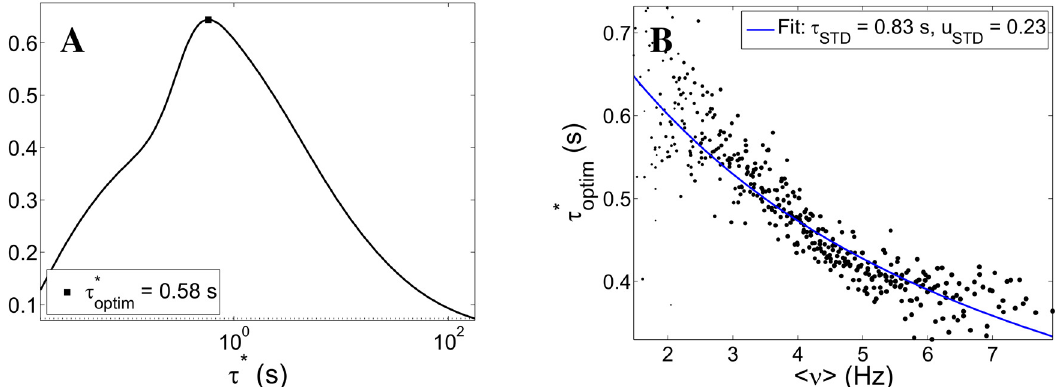
Fig 7. Slow time-scales inference procedure: test on simulation data. Panel A: correlation between low-pass filtered network activity f (see Eq 19) and the size of the immediately subsequent network spike plotted against the time-scale τ * of the low-pass integrator (continuous line). The correlation presents a clear (negative) peak for an ‘ optimal ’ value t (cid:8) optim ¼ 0 : 58 s of the low-pass integrator; such value is interpreted as the effective time-scale of the putative slow self-inhibitory mechanism underlying the statistics of network events — in this case, short-term synaptic depression (STD); as a reference, the dotted line marks the value computed for surrogate data (see text). Panel B: for each point in the (w exc , w inh )-plane (see Fig 2), t (cid:8) optim vs average network activity; the continuous line is the best fi t of the theoretical expectation for STD ’ s effective time-scale (Eq 20); the fi tted values for the STD parameters τ STD and u STD are consistent with the actual values used in simulation ( τ STD = 0.8 s, u STD = 0.2).